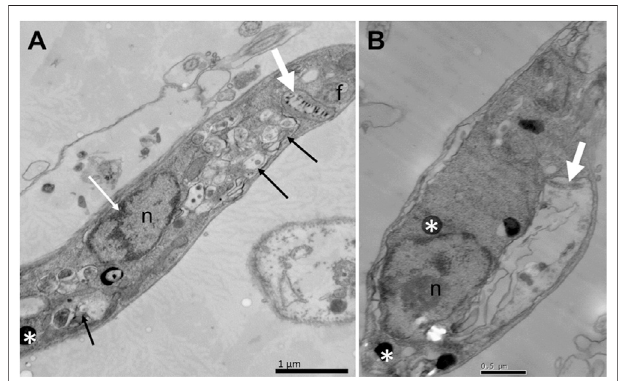
FIGURE 6 | Ultrastructural alterations of Leishmania amazonensis promastigote forms treated with luteolin at 25 μ g/mL for 24 h. Small vacuoles containingelectron-densemicrovesiclesdispersedbythecytoplasm(arrows), change in the nuclear chromatin (white arrow) (A) ; lipid bodies (white asterisks),kinetoplast and mitochondriafully degenerated (white thick arrows) (A – B) . n: nucleus; f: fl agellum.